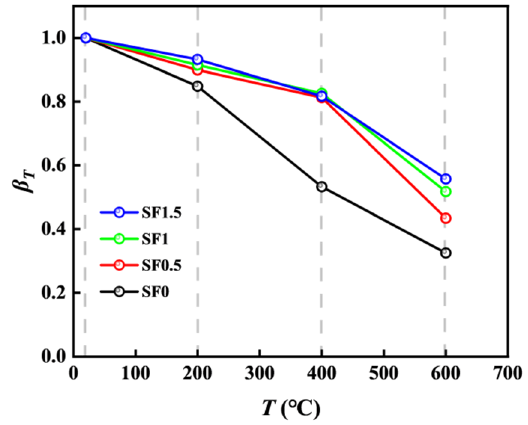
Figure 12. β T – T curves.